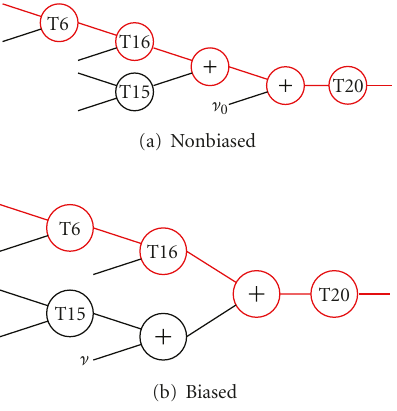
Figure 4: Comparison of two approaches to regularization of division in T20 . The critical path fragment is marked in